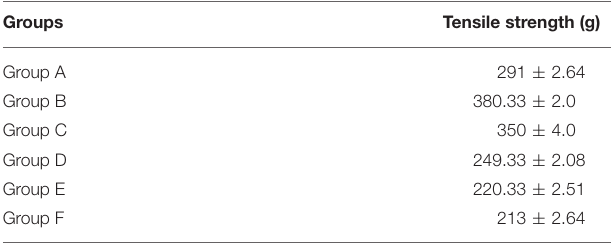
Frontiers in Microbiology |